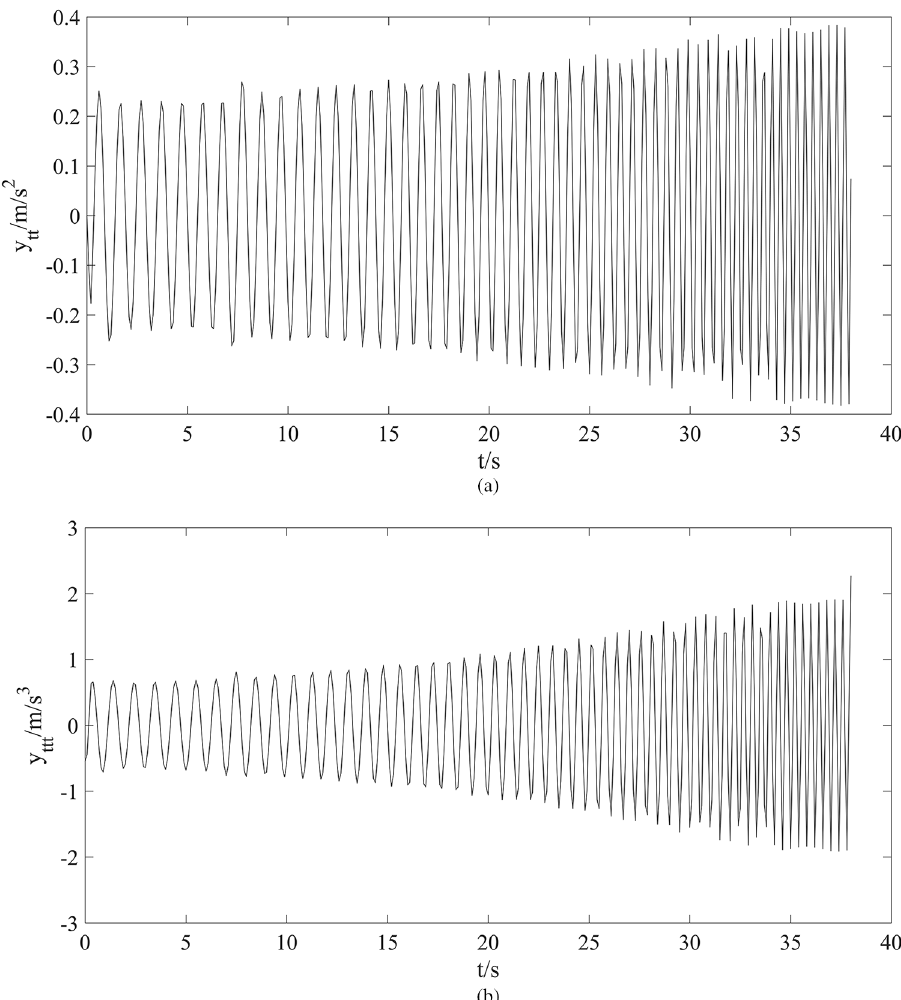
Fig. 4. Lifting system longitudinal acceleration and jerk response determination section. (a) Acceleration response (b) Jerk response.